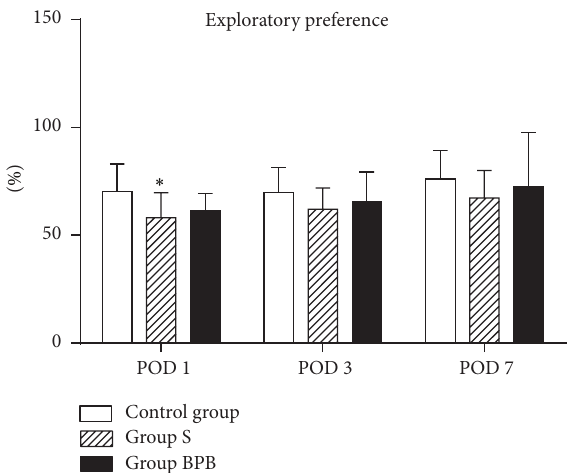
Figure 3: Effect of brachial plexus block on recognition memory assessed by the novel object recognition test. Each bar represents mean ± SEM( 𝑛 = 12 ineach group). ∗ 𝑃 < 0.05 versuscontrol group. POD = postoperative